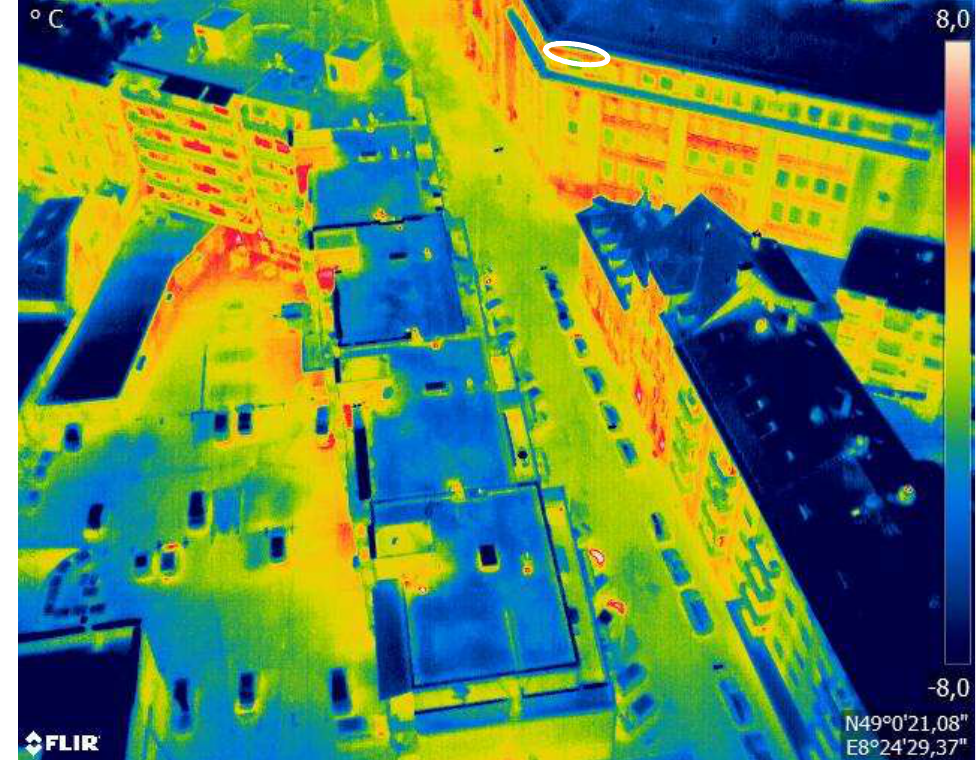
Figure A15. Example: thermal bridge of a window lintel.